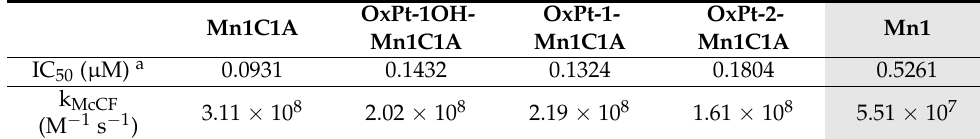
Table 1. SOD activity values determined by the McCord–Fridovich assay.